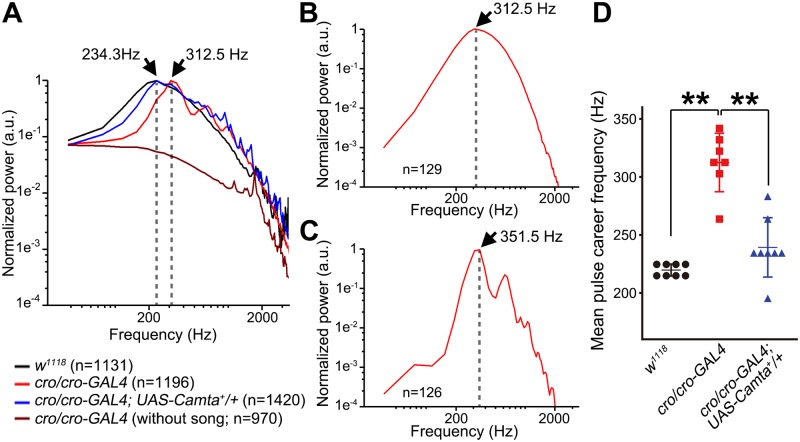
cro affects carrier frequency characteristics of song pulses.(A-C) Power spectra of pulse songs recorded from male flies of w1118 (A: black) and cro/cro-GAL4 without (A-C: red) or with (A: blue) UAS-Camta+. The drawn line represents a power spectrum of traces with no song recorded from cro/cro-GAL4, which is indistinguishable from similar spectra of traces containing no song (i.e., noise only) obtained from other genotypes. cro/cro-GAL4 monocyclic (B) and polycyclic (C) pulses separately subjected to fast Fourier transformation yield distinctly different power spectra. Spectra illustrated in (B) and (C) but not (A) have been noise-subtracted. Perpendicular broken lines indicate the maximal peak frequency. (D) The maximal peak frequency estimated in different flies of the indicated genotypes is compared. The means ± SEM are indicated by horizontal and vertical bars superimposed on the data points. The statistical significance of differences was evaluated by Kruskal-Wallis analysis followed by Steel-Dwass nonparametric multiple comparisons; **: P<0.01.